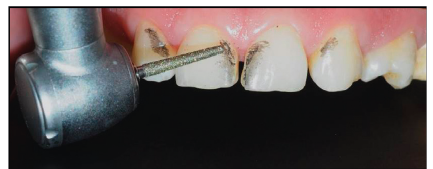
Figure 7: Regions selected to receive selective wear.